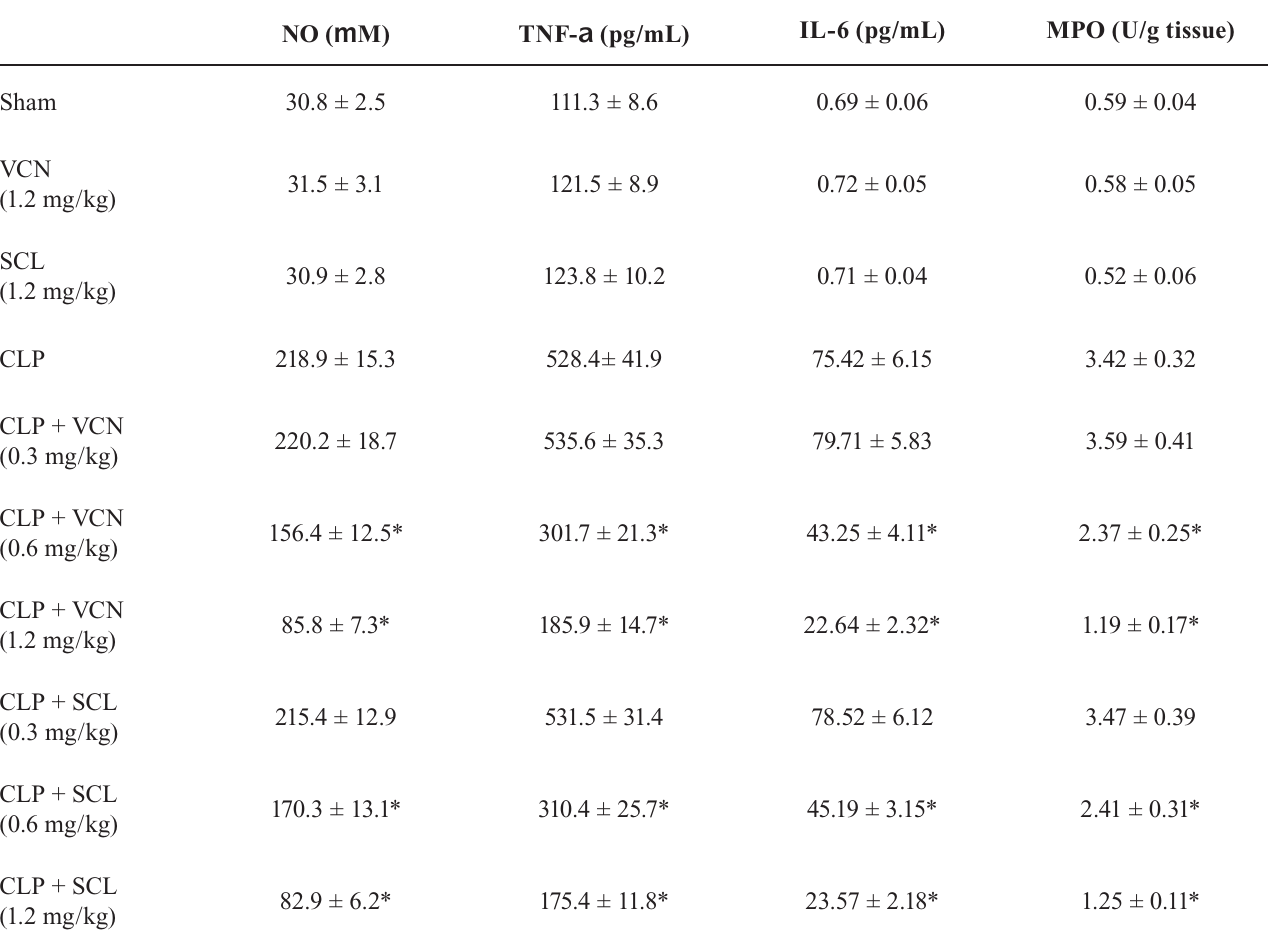
TABLE II - Effects of VCN or SCL treatment on NO, TNF-, IL-6 levels and renal MPO activity in CLP-operated